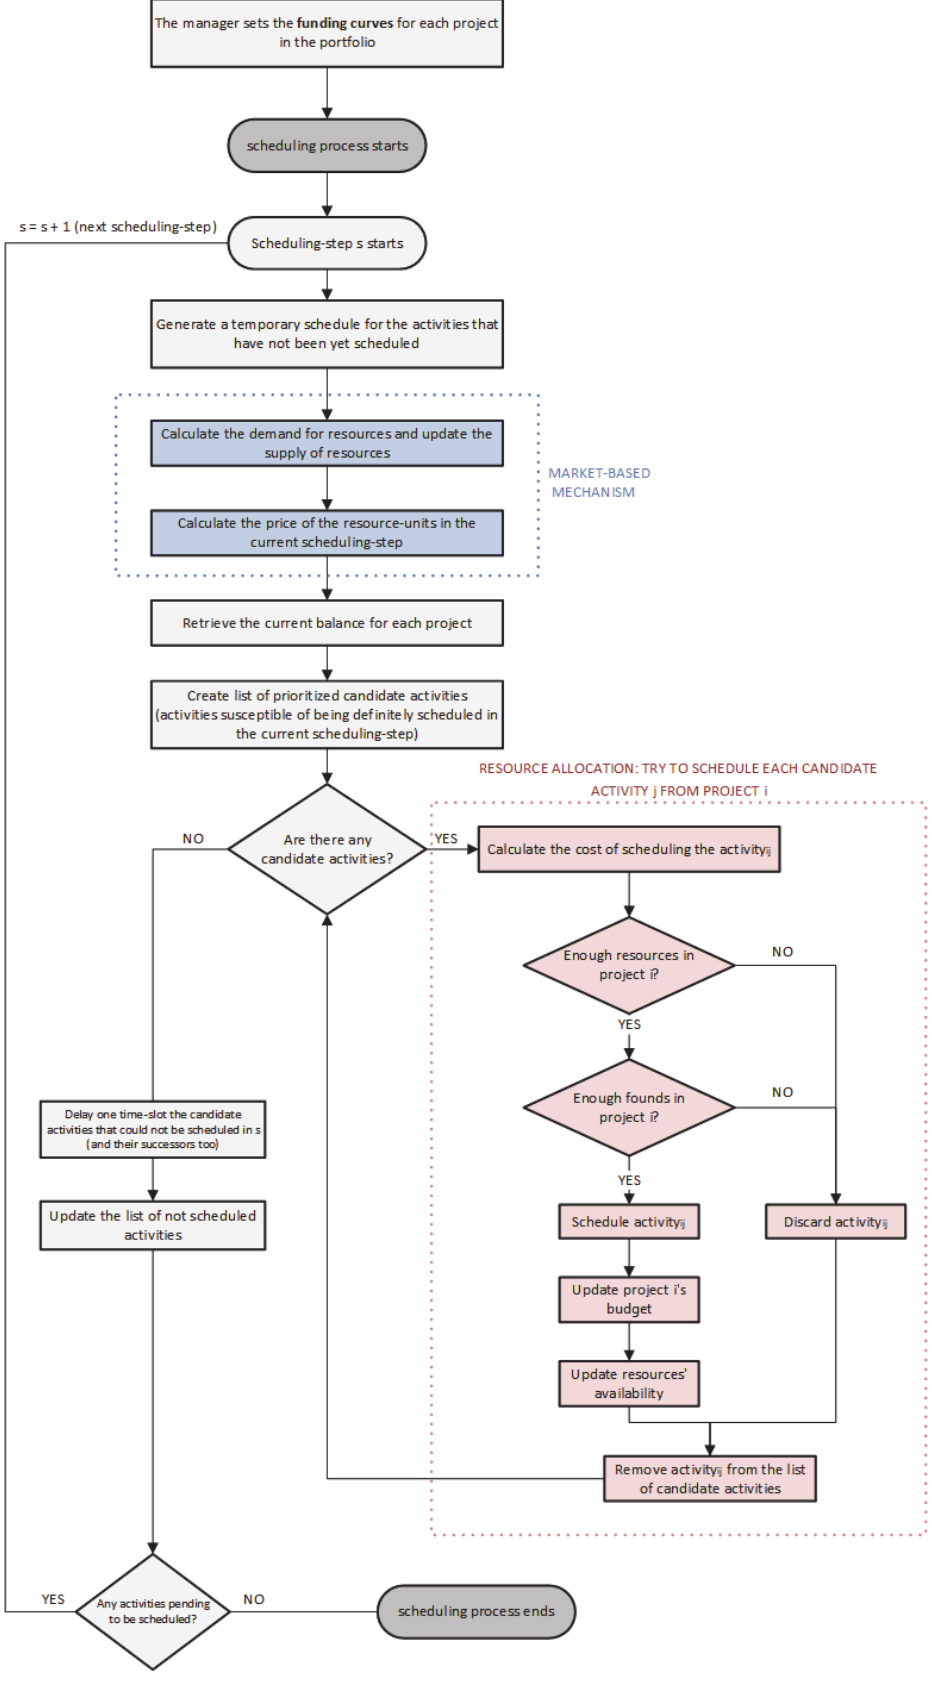
Fig. 3. Flowchart of the